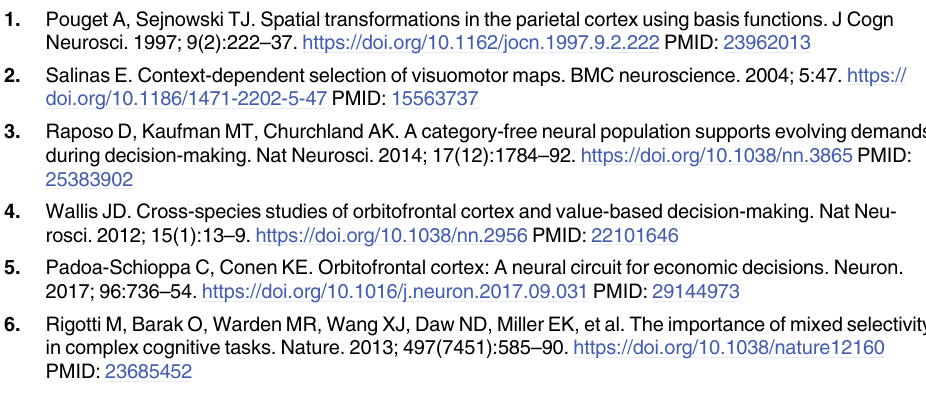
of clusters is the same as for the full data set. The x-axis represents offer types ranked by the ratio #B:#A. The y-axis in red represents normalized response rates. The y-axis in black shows monkey behavior. Red diamonds represent the responses to chosen juice A whereas red dots represent the responses to chosen juice B. The separate red diamond and red dot show forced choices. S13 Fig. Tuning curves of post-juice response prototypes as defined by 4 cluster centers. Like Fig 9 but for 4 cluster and 2 variables. The x-axis represents offer types ranked by the ratio #B:#A. The y-axis in red represents normalized response rates. The y-axis in black shows mon- key behavior. Red diamonds represent the responses to chosen juice A whereas red dots repre- sent the responses to chosen juice B. The separate red diamond and red dot show forced